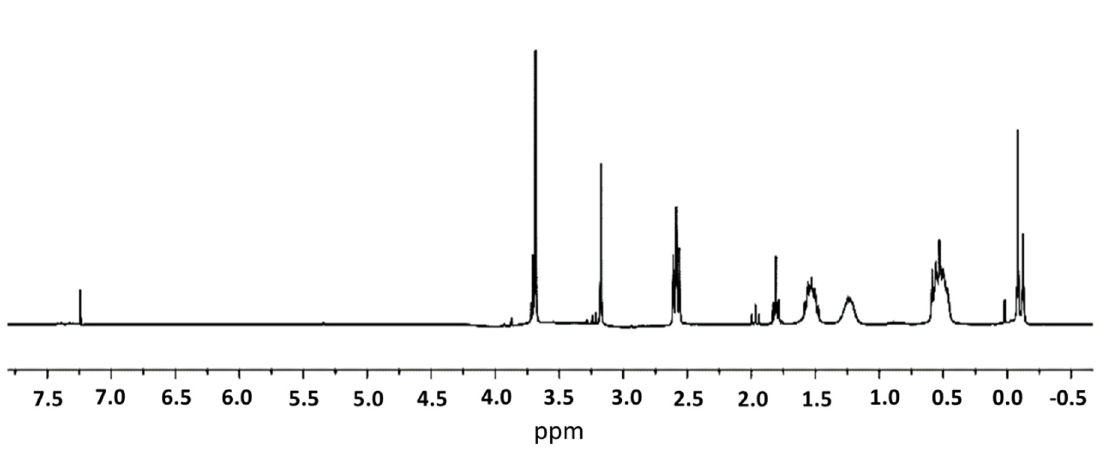
Figure 3. 1 H-NMR of G 3 Si(SC 2 H 4 NH 2 )(SCH 2 CO 2 CH 3 ) 31 (II) in CDCl 3 .